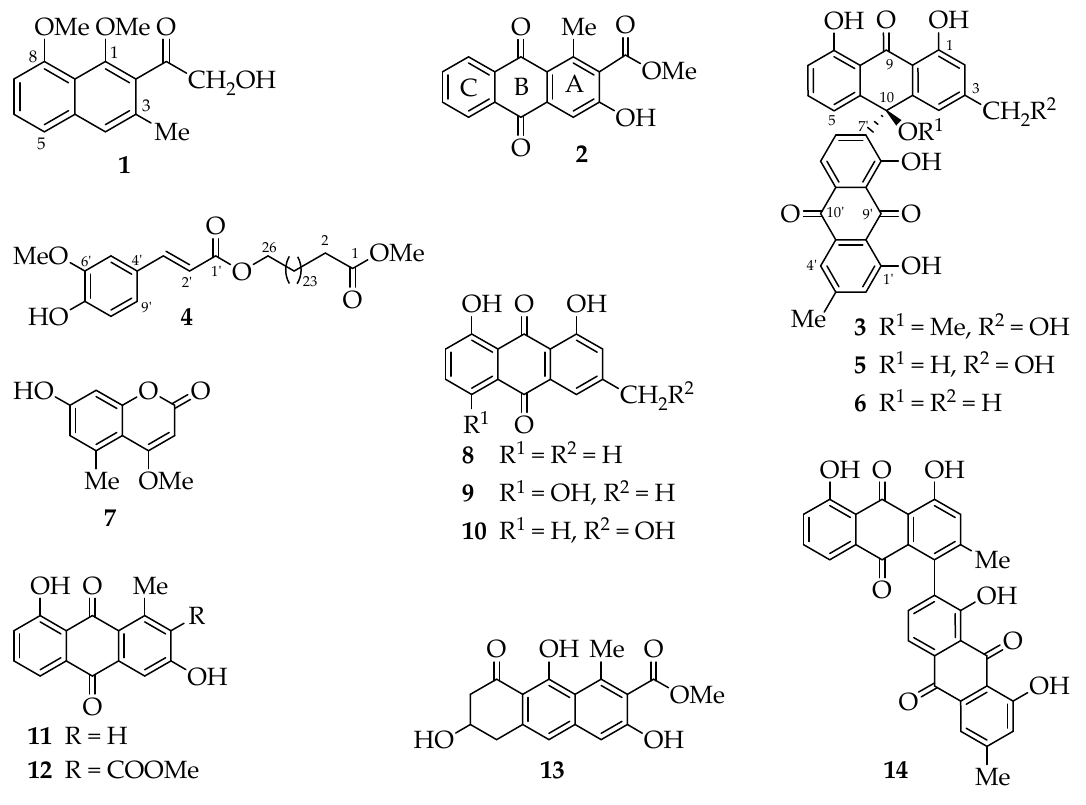
Figure 1. Structures of the compounds.